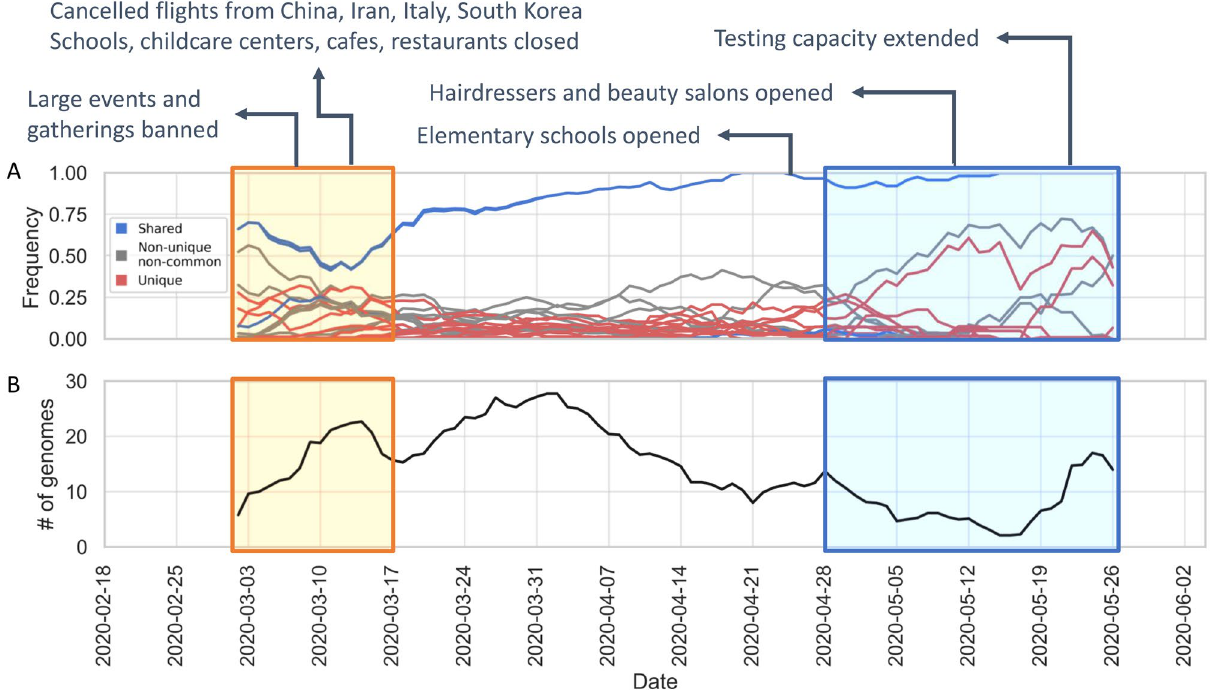
Figure 7. ( A ) Change in frequency of the top 15 mutations in the Netherlands, averaged over a period of 7 days and removed periods with less than one sample per day. Each line represents the abundance of a specific mutation over time. Line colors were kept consistent with Figs. 5 and 6: blue lines are mutations shared across all these countries in the top 15, while the red lines are unique to that one country in the top 15 and the gray lines are non-unique and non-common variants where the mutation is observed in more than one country. Areas highlighted in yellow and blue indicate pre-lockdown and post-lockdown respectively. Major milestones in the national response against COVID-19 are annotated at the top. ( B ) Number of submitted genome sequences in the Netherlands, averaged over a period of 7 days and removed periods with less dan one